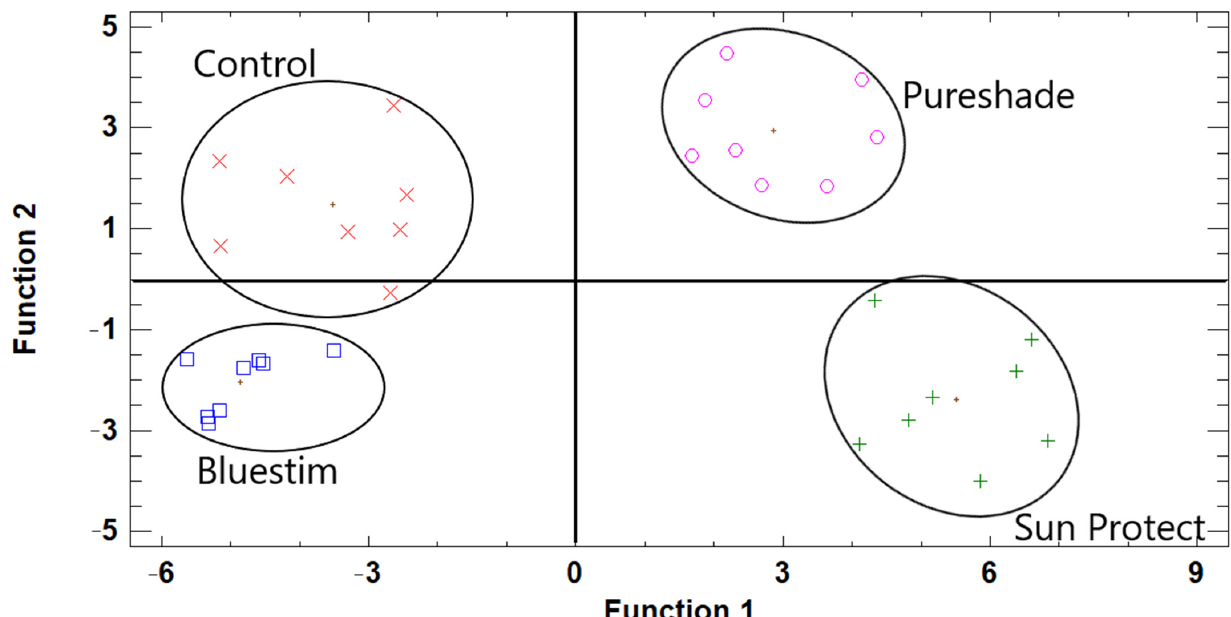
Figure 6. Plot of discriminant functions produced from the data of the third sampling on September 21st.